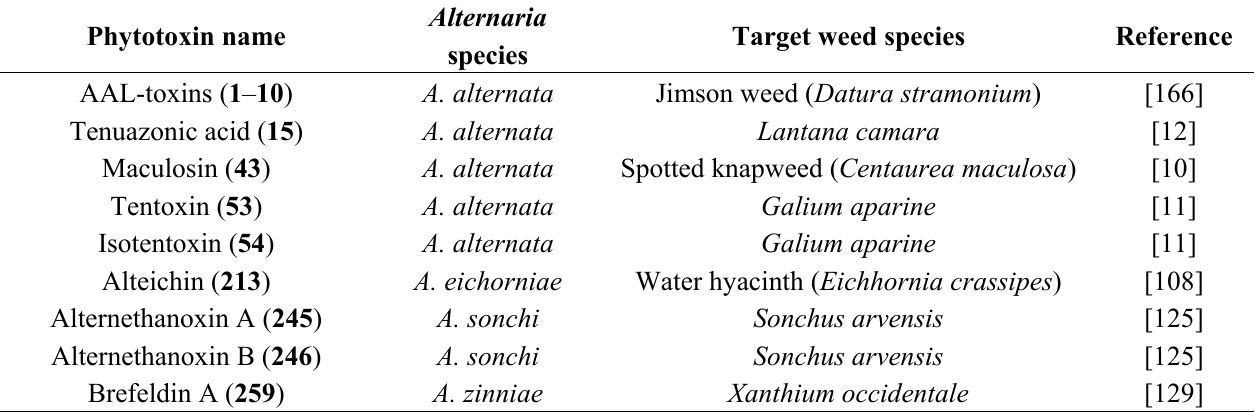
Table 3. Some examples of Alternaria phytotoxins which are toxic to weed